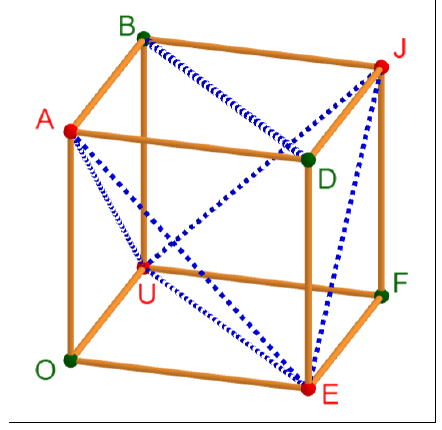
Figure 10. Is this a rigid cube?